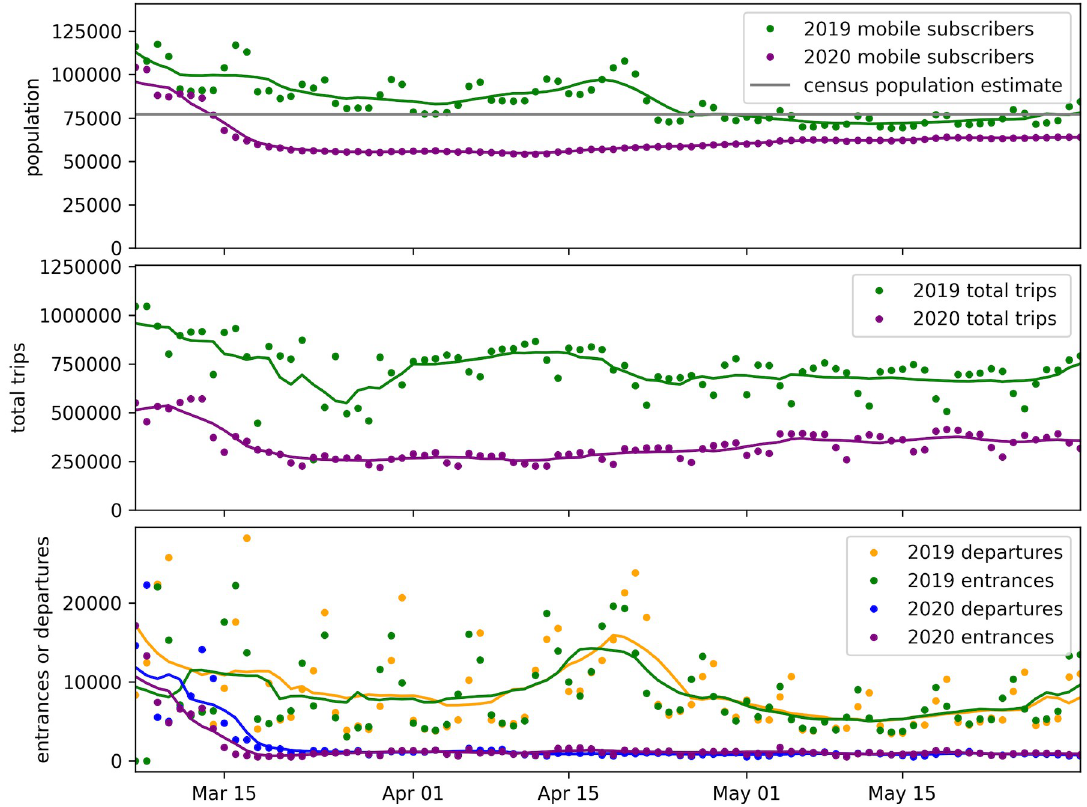
Fig 3. Estimated population, trips, country entrances and departures metrics for 2020 vs 2019. (Top) daily mobile subscribers counted as present in the country, (middle) daily total trips, and (bottom) daily country entrances and departures, for the country of Andorra during the start of the pandemic in 2020 versus the same period in 2019. All metrics are estimated from telecoms data that covers 100% of mobile subscribers in the country. Solid lines show values smoothed over a 7-day rolling window.